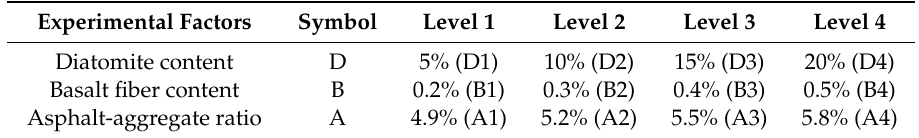
Table 5. Experimental factors and their